Question: In one sentence, what is this figure communicating?
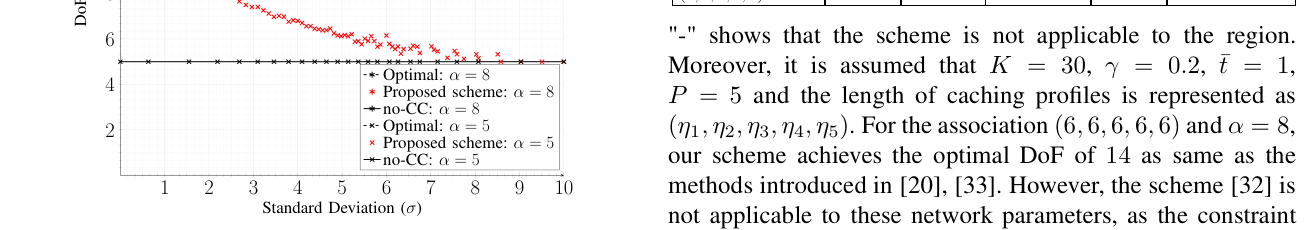
Answer: The average of the maximum achievable DoF (DoFM) versus the standard deviation (σ) with K = 30, γ = 0.2, P = 5, ¯t = 1 and α ∈{5, 8}.